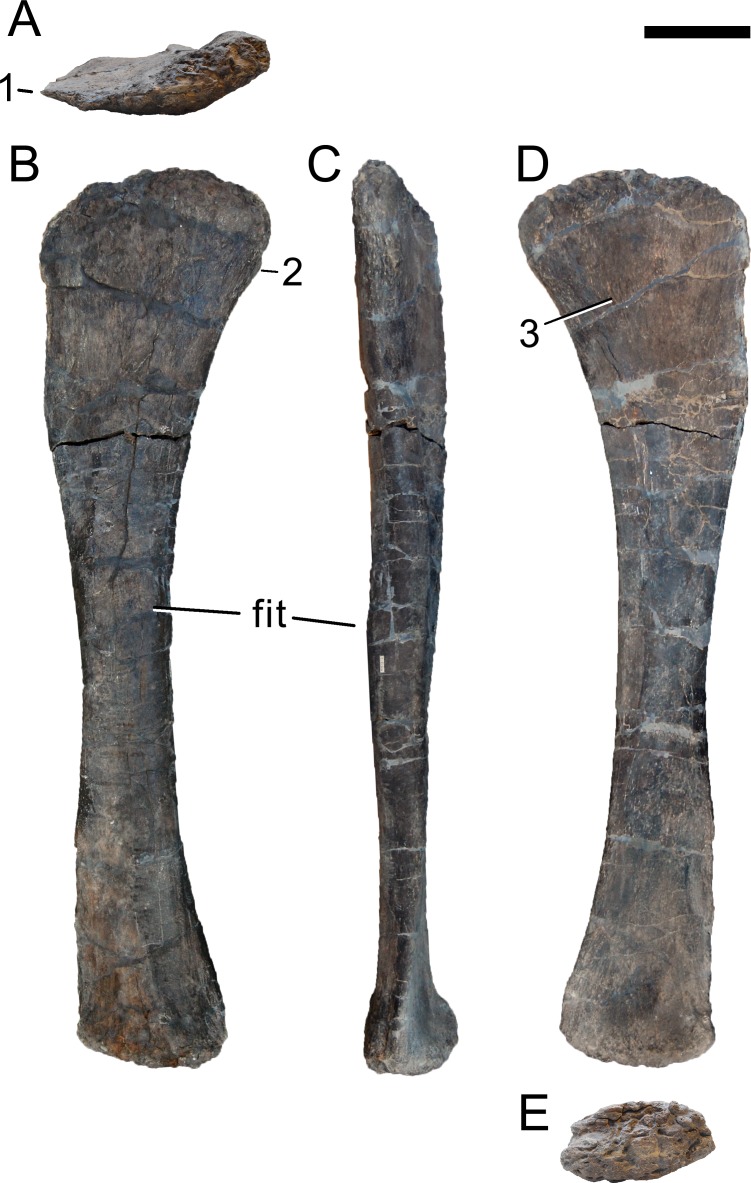
Left fibula of Galeamopus pabsti SMA 0011.The fibula is shown in proximal (A), lateral (B), posterior (C), medial (D), and distal (E) view. Note the anteromedially projecting process on the proximal articular surface (1), the short longitudinal ridge on the posterior surface (2), and the striated rugosity on the medial surface (3). Abb.: fit, fibular trochanter. Scale bar = 10 cm.